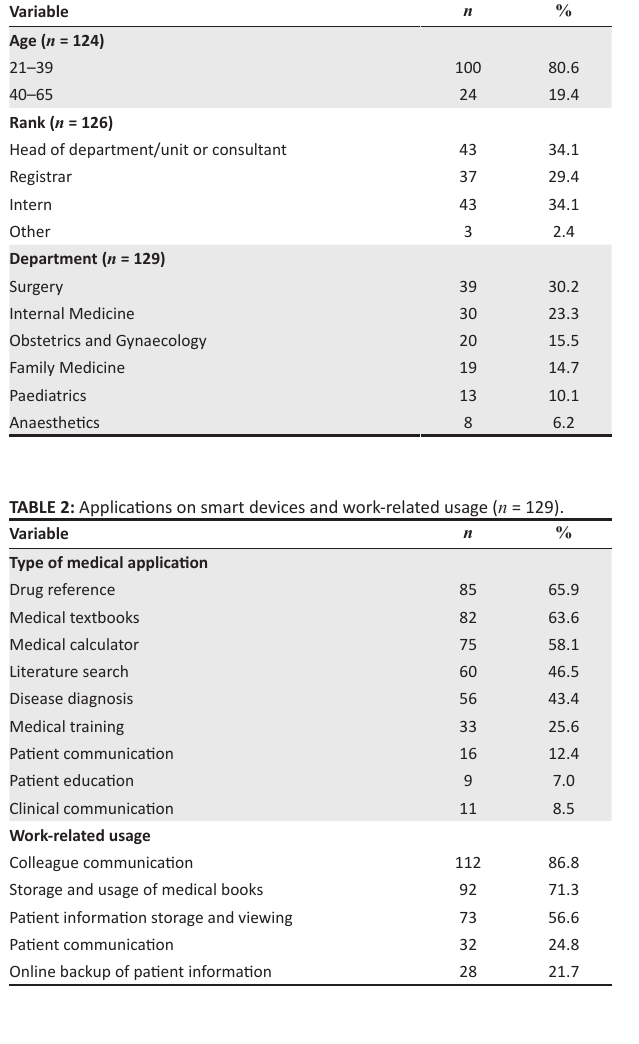
TABLE 1: Demographic information of participating medical